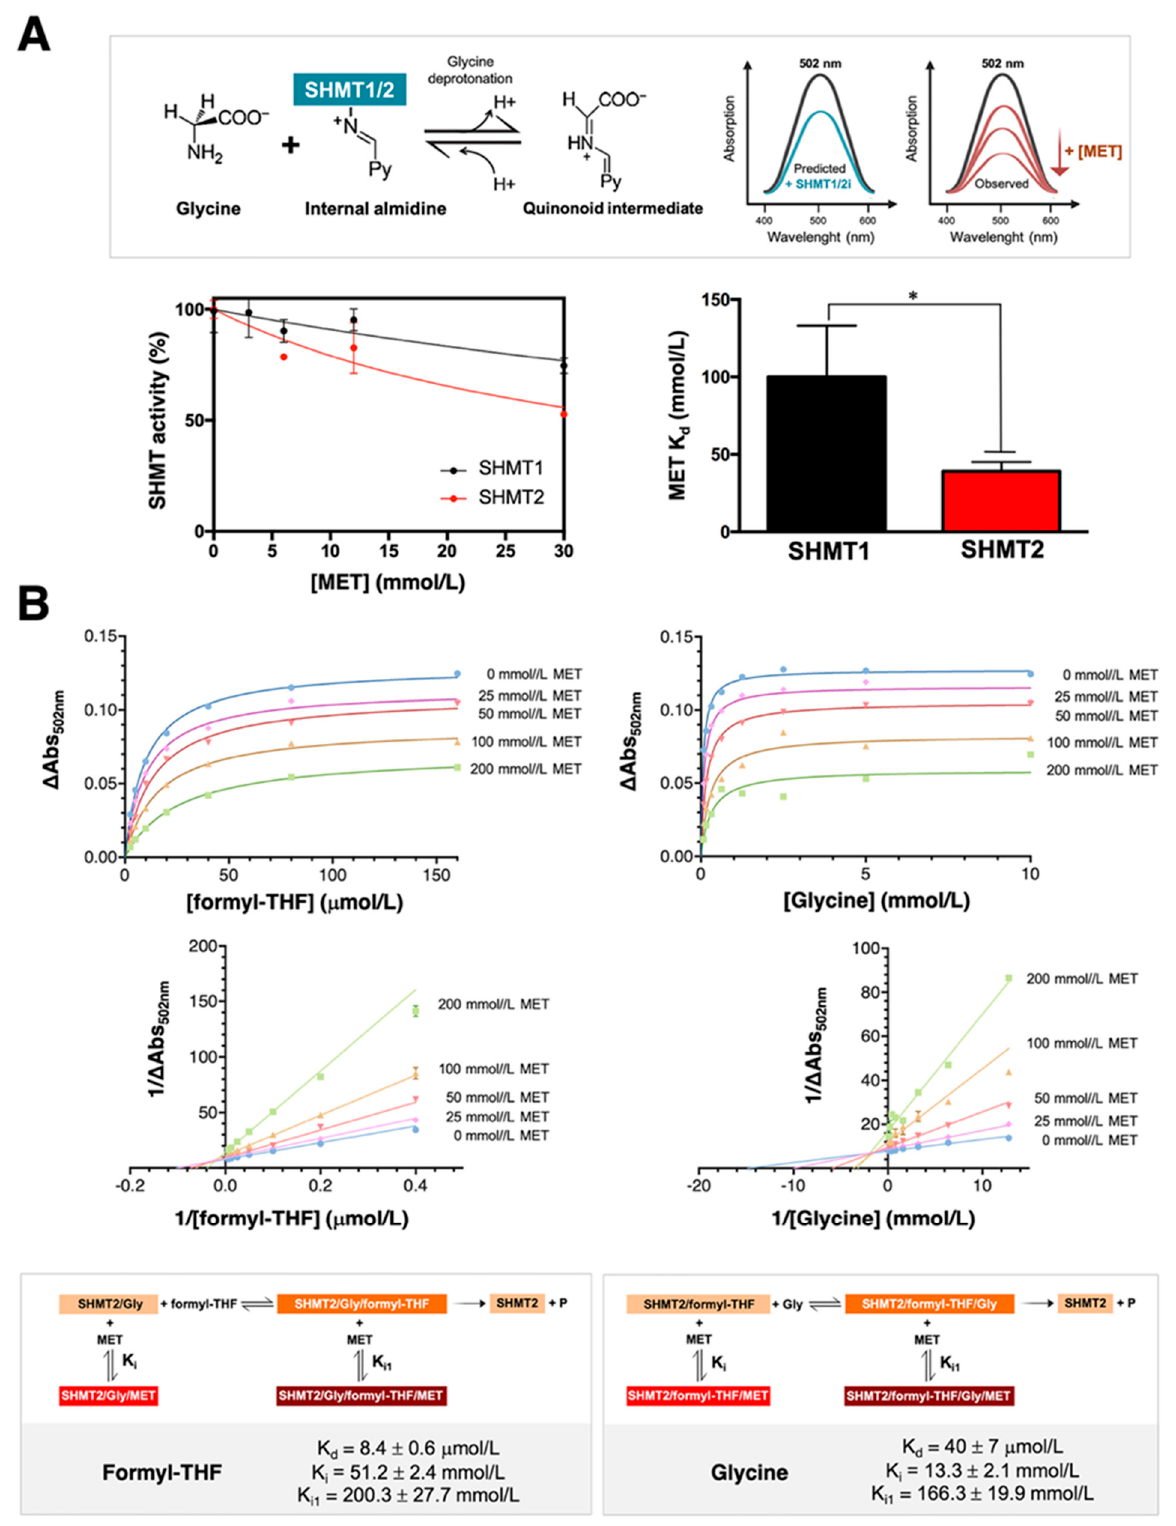
Figure 1. Metformin inhibits the catalytic activity of human purified SHMT2. ( A ) Top . The quinonoid intermediate formed upon binding of glycine to SHMTs accumulates only when a folate ligand is simultaneously bound to the enzyme, thereby forming an enzyme–glycine–folate ternary complex. In the scheme, the pyridine ring of the cofactor is indicated by Py. Bottom . The activity of purified (5 µ mol/L) recombinant SHMT1 (black symbols) and SHMT2 (red symbols) was measured in the presence of 5 µ mol/L formyl-THF, a saturating concentration of glycine (3 mmol/L) and increasing concentrations of metformin (MET) (0–30